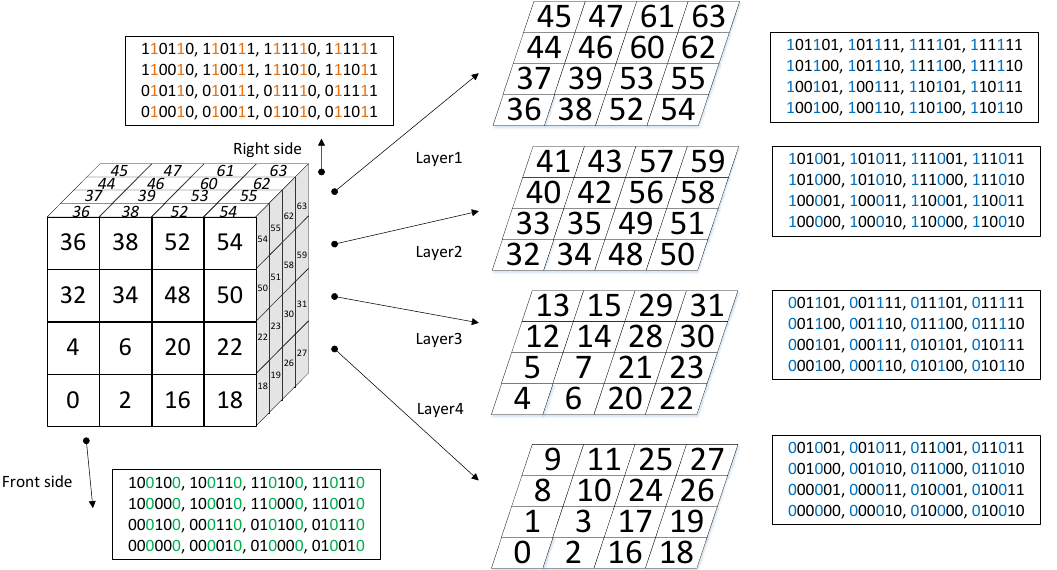
Figure 1. Detailed illustration of GeoSOT-3D grids on Level 2. The codes for the three-dimensional grids are marked on the surface of the cube and on four separate layers. The binary codes are also listed for the front side, right side, and each layer.